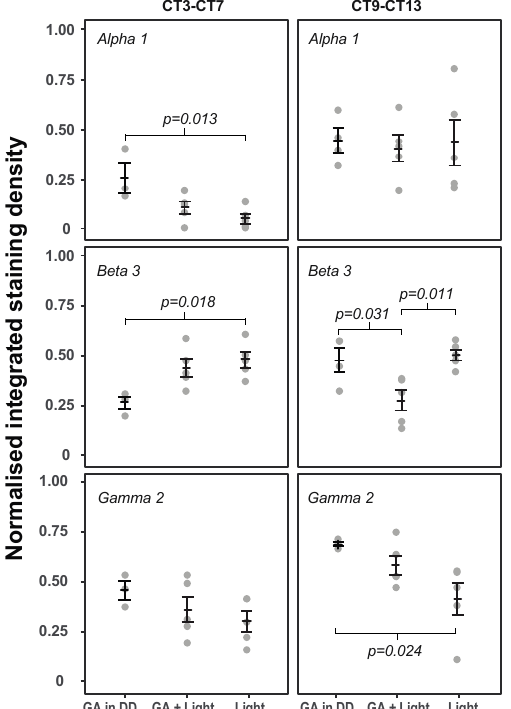
Figure 4. Quantification of GABA A R α 1, β 3, and γ 2 subunit immunoreactivity in the mouse SCN in response to GA and light treatments. The data are graphed as individual means ± SEM. (significant differences (Tukey’s HSD ( p < 0.05)) are shown). Table 3. Summary statistics of GABA A R subunit expression during late circadian times at which phase shifts due to light and GA are maximal (CT9–CT13). Evidence of differences between treatment groups was tested using ANOVA. Different treatments that share the same superscript number indicate the difference between them is statistically significant (Tukey’s HSD p < 0.05).